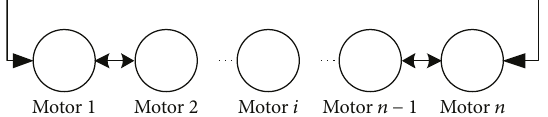
Figure 3: Simpli fi ed structure of synchronization